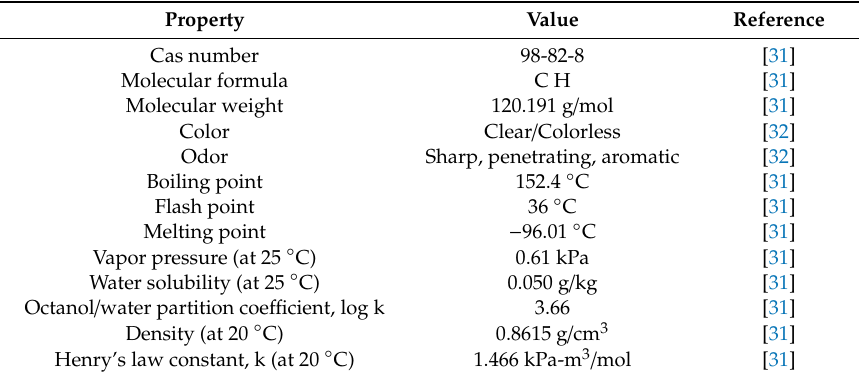
Table 2. Select properties of